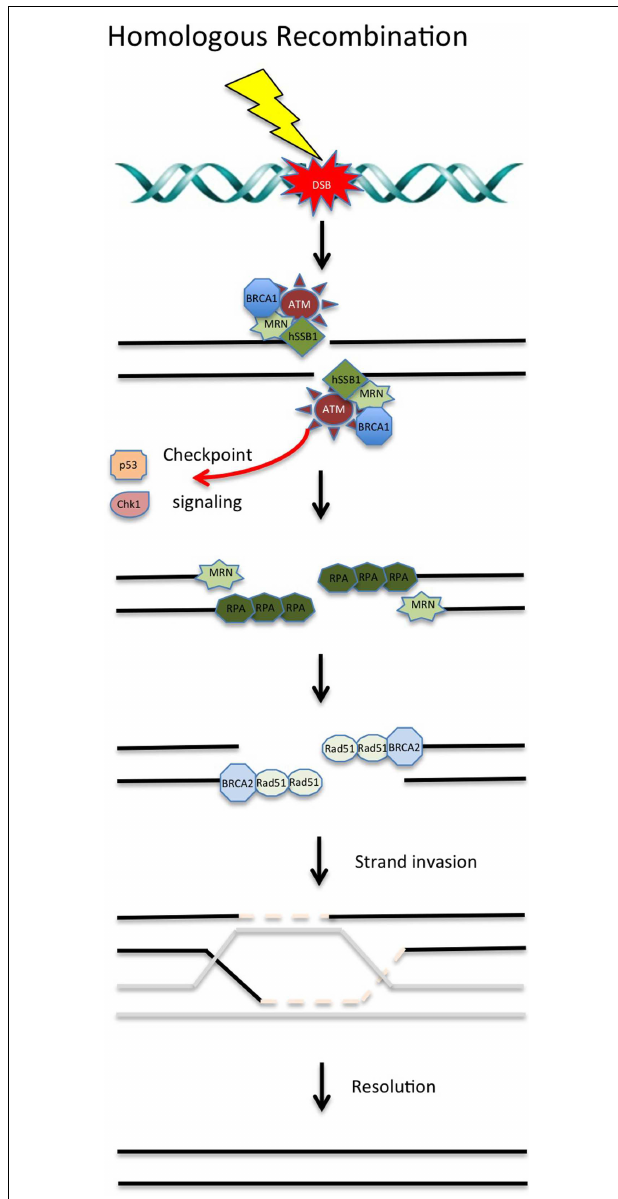
FIGURE 1 | DNA double-strand break repair via homologous recombination . During S and G2 phases of the cell cycle, DSBs can be repaired via HR using a sister chromatid.Targeting of these proteins involved in HR with chemotherapeutic compounds shows promise in the clinical setting. See text for